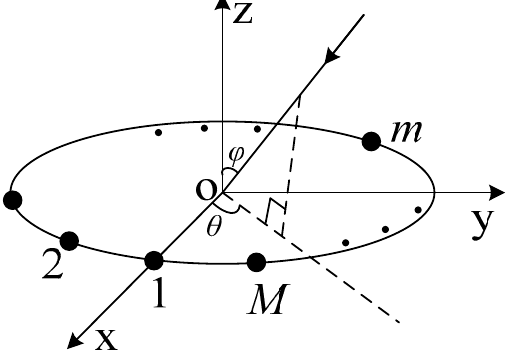
Figure 1. Structure of the uniform circular EVSA.